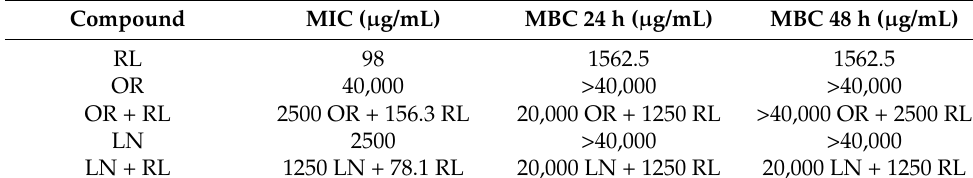
Table 2. Antimicrobial activity of the tested compounds against B. cereus vegetative cells.